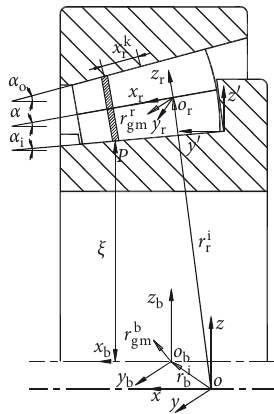
Figure 2: Geometric interaction between the roller and